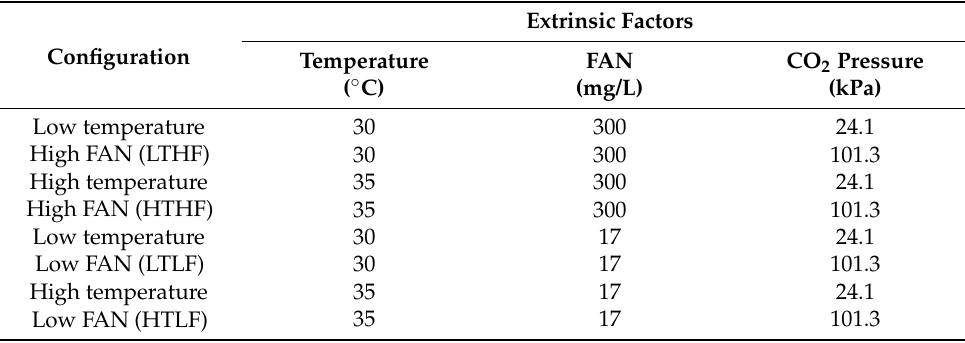
Table 2. Setup of extrinsic factors under each fermentation configuration.